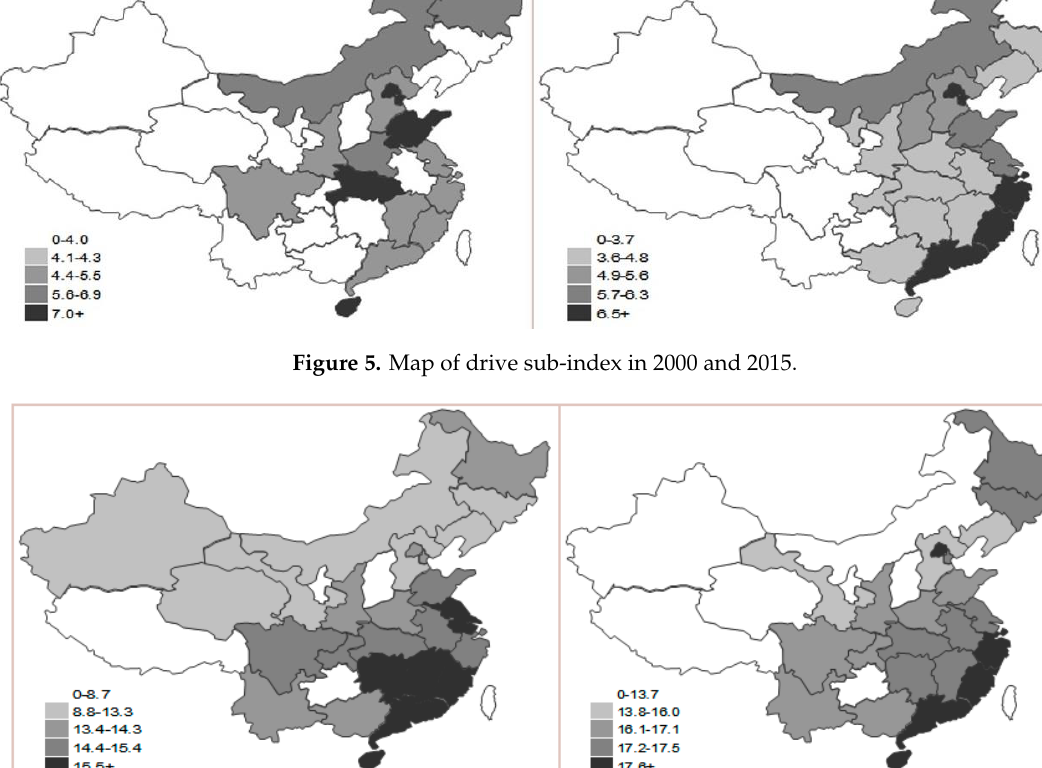
Figure 7. Map of state sub-index in 2000 and 2015.